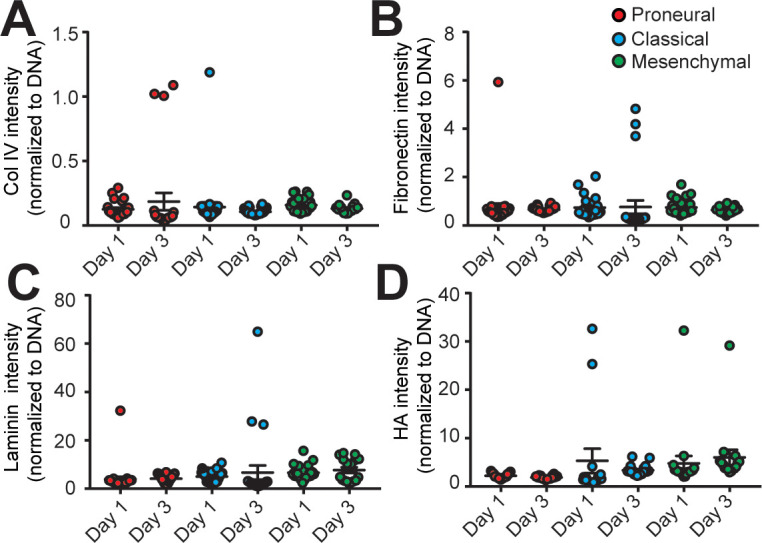
Analysis of extracellular matrix composition in different engineered GBM niches.The quantified results of (A) Collagen IV (Col IV), (B) Fibronectin, (C) Laminin, and (D) hyaluronic acid (HA) depositions in the MES (GBML91), CL (GBML08) and PN (GBML20) GBM niches showed no significant changes in the 3-day culture period. Error bars represent ± s.e.m.